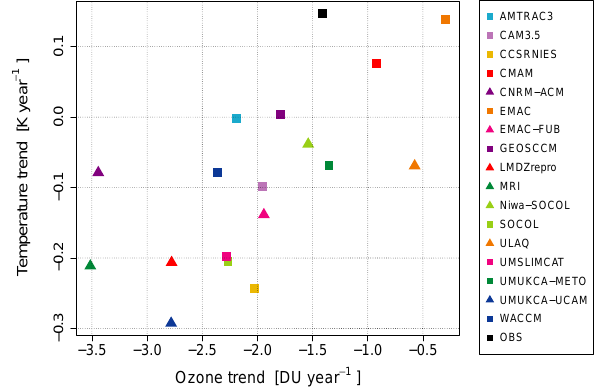
Figure 6. Scatter diagram of the linear trends in the Antarc- tic total column ozone (in DUyr − 1 ) and the Antarctic tempera- ture at 100hPa (in Kyr − 1 ) in September–October–November be- tween 1960 and 1980 for the 17 CCMs of this study and the obser-